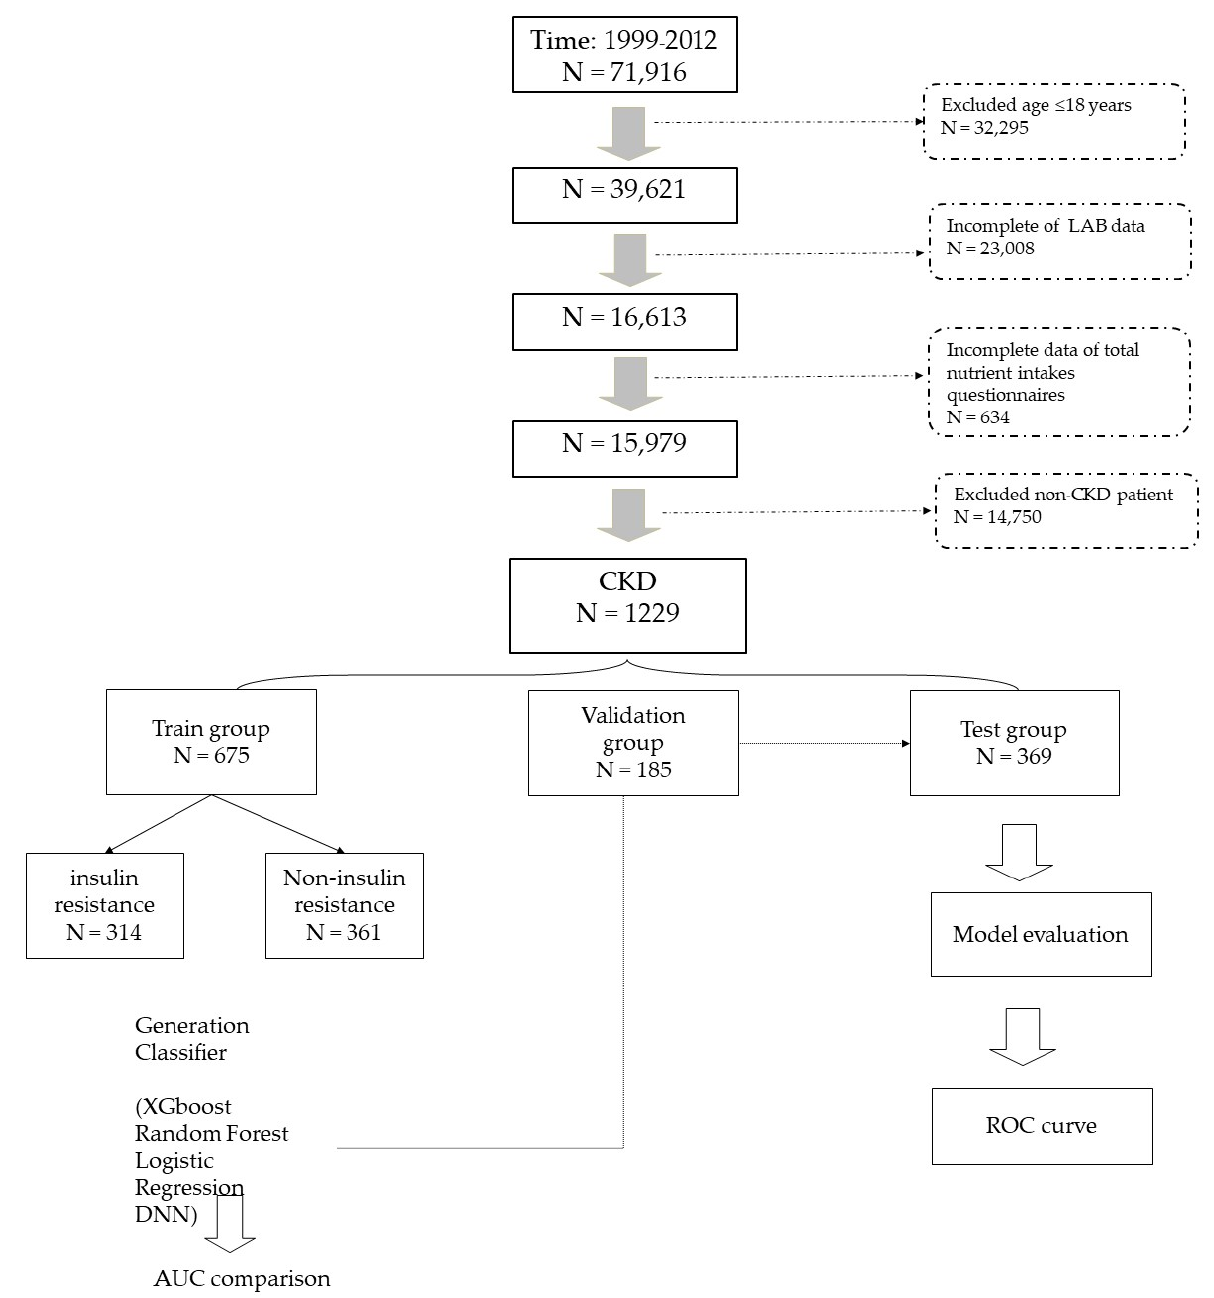
Figure 1. Algorithm of groping in patients with CKD. Initially, all 71,916 participants were enrolled in this study. After exclusion, all 1229 participants with CKD with complete data were analyzed. We separated all 1229 participants into three groups: 675 for train group, 185 for validation group, and 369 for test group. All algorithms were compared via AUC.